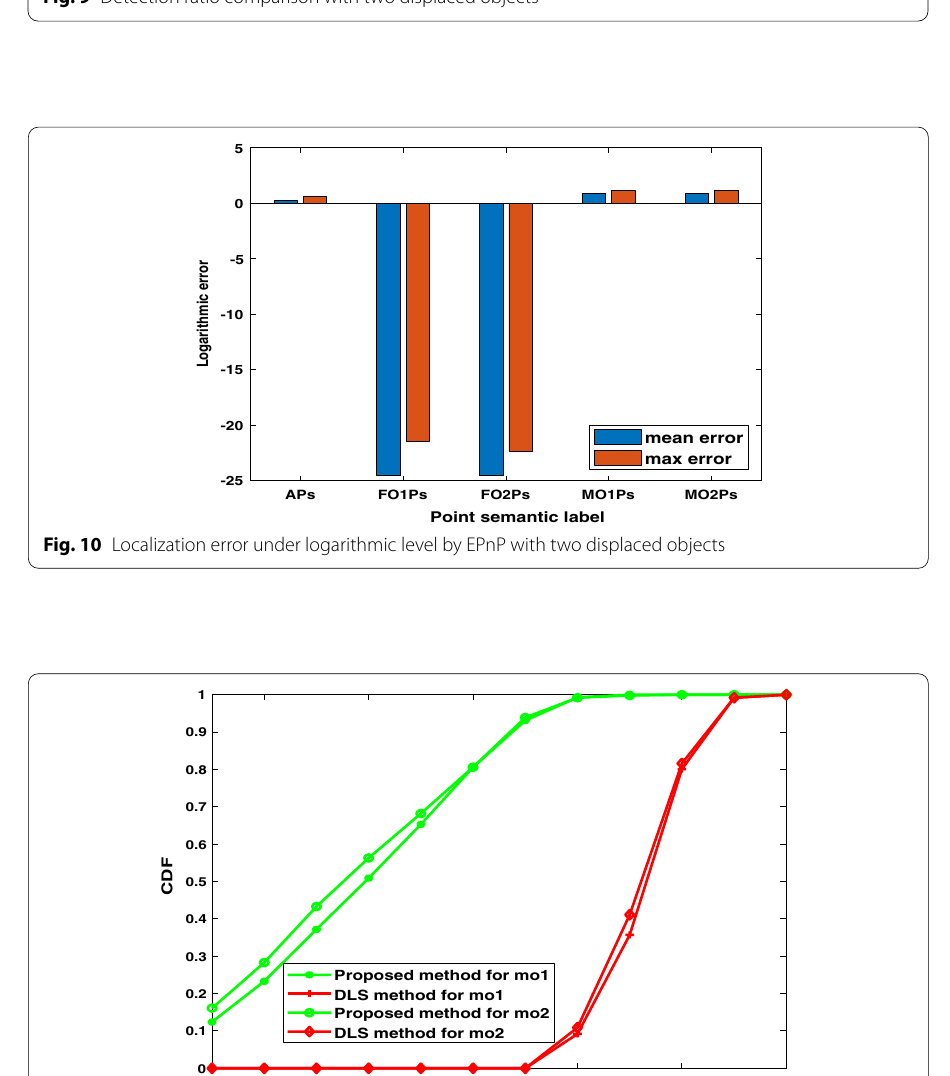
Fig. 9 Detection ratio comparison with two displaced objects